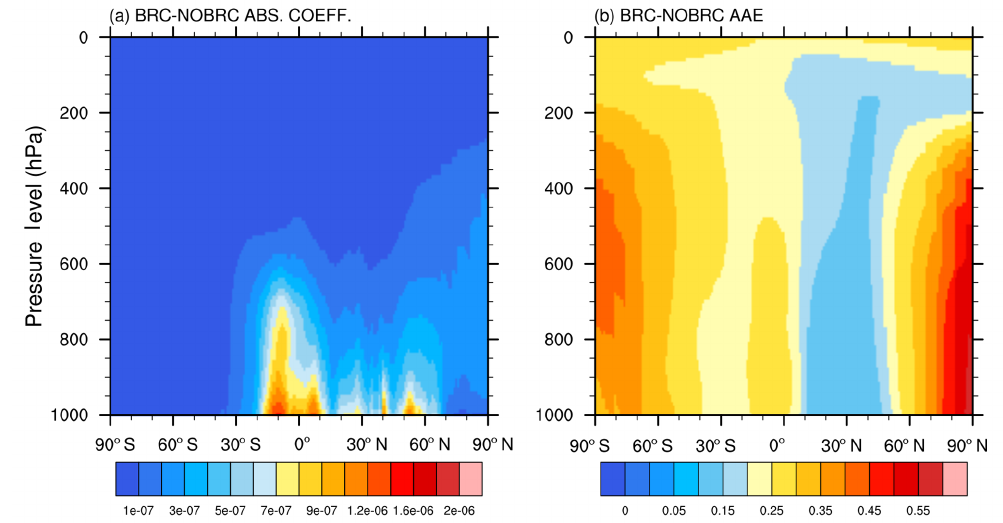
Figure 6. Differences in (a) the zonally averaged absorption coefficient (m − 1 ) and (b) the zonally averaged AAE between the BRC model run and the NOBRC model run.